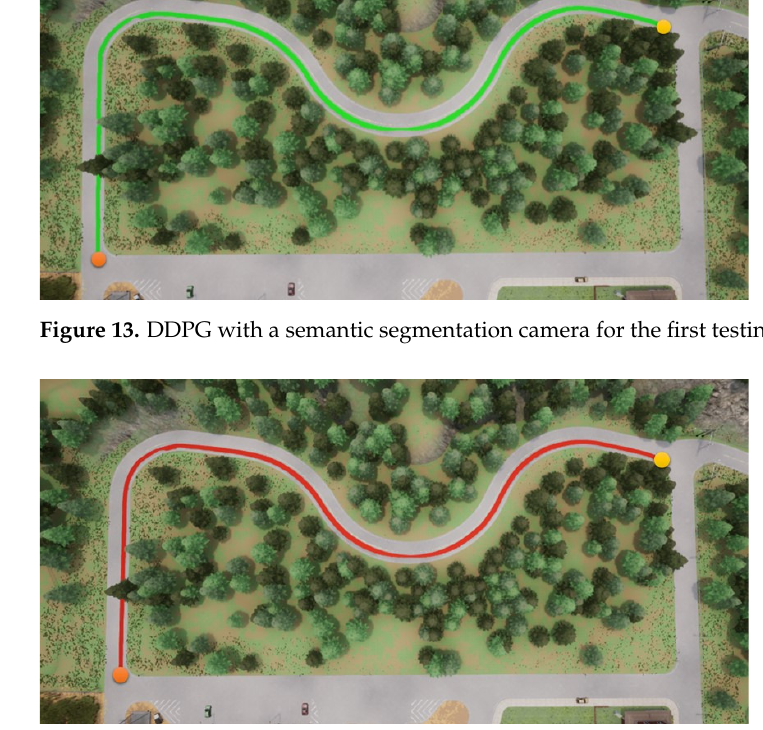
Figure 14. RDPG with an RGB camera for the first testing